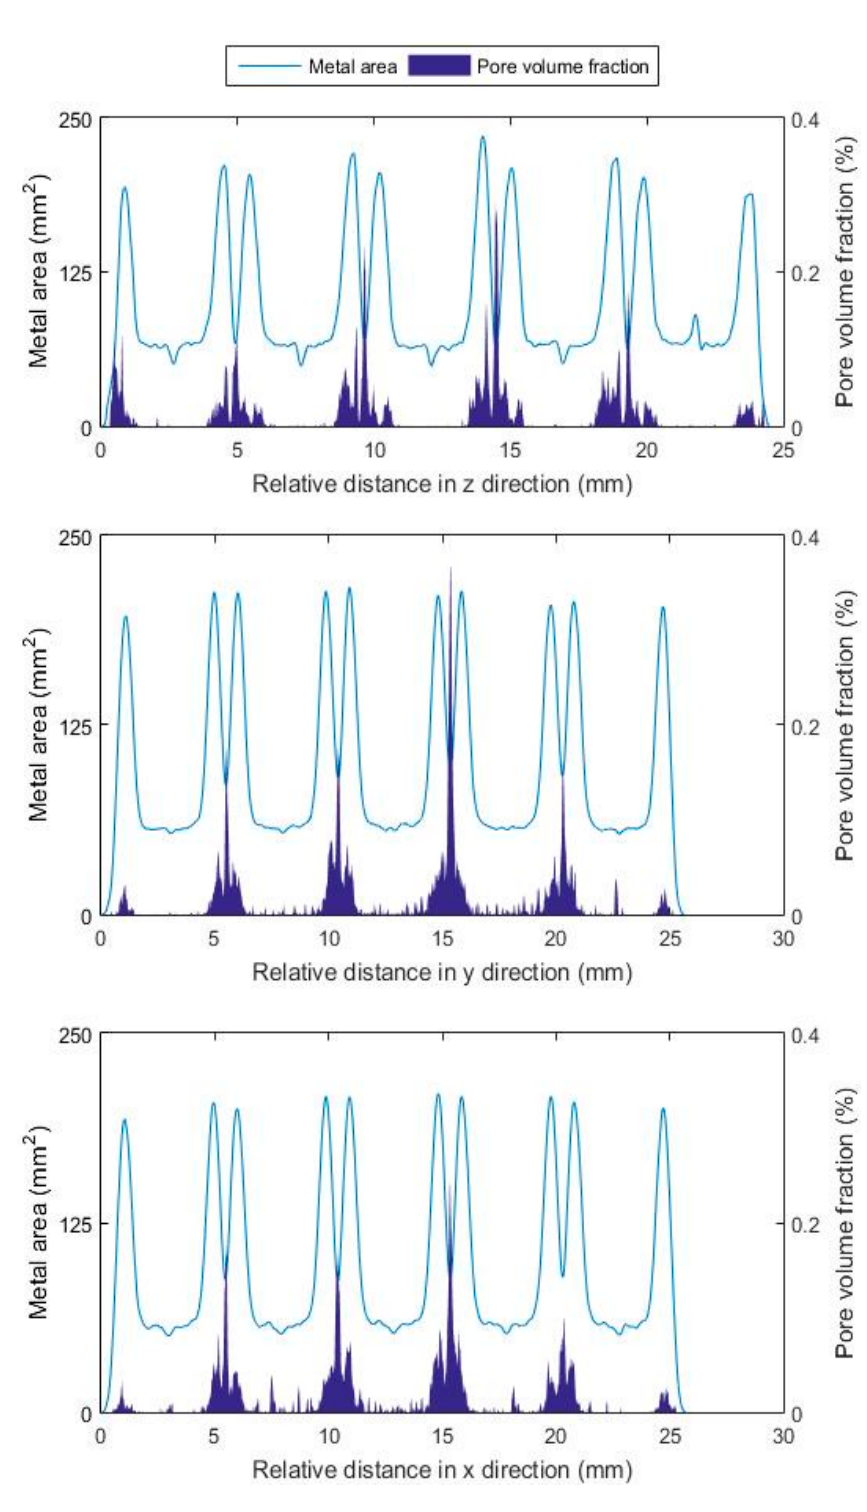
Figure 6. Metal area and pore fraction per slice with distance from the edge of the re-entrant cube sample. Top image shows the z direction parallel to the build direction, middle and bottom images the other two orthogonal directions.